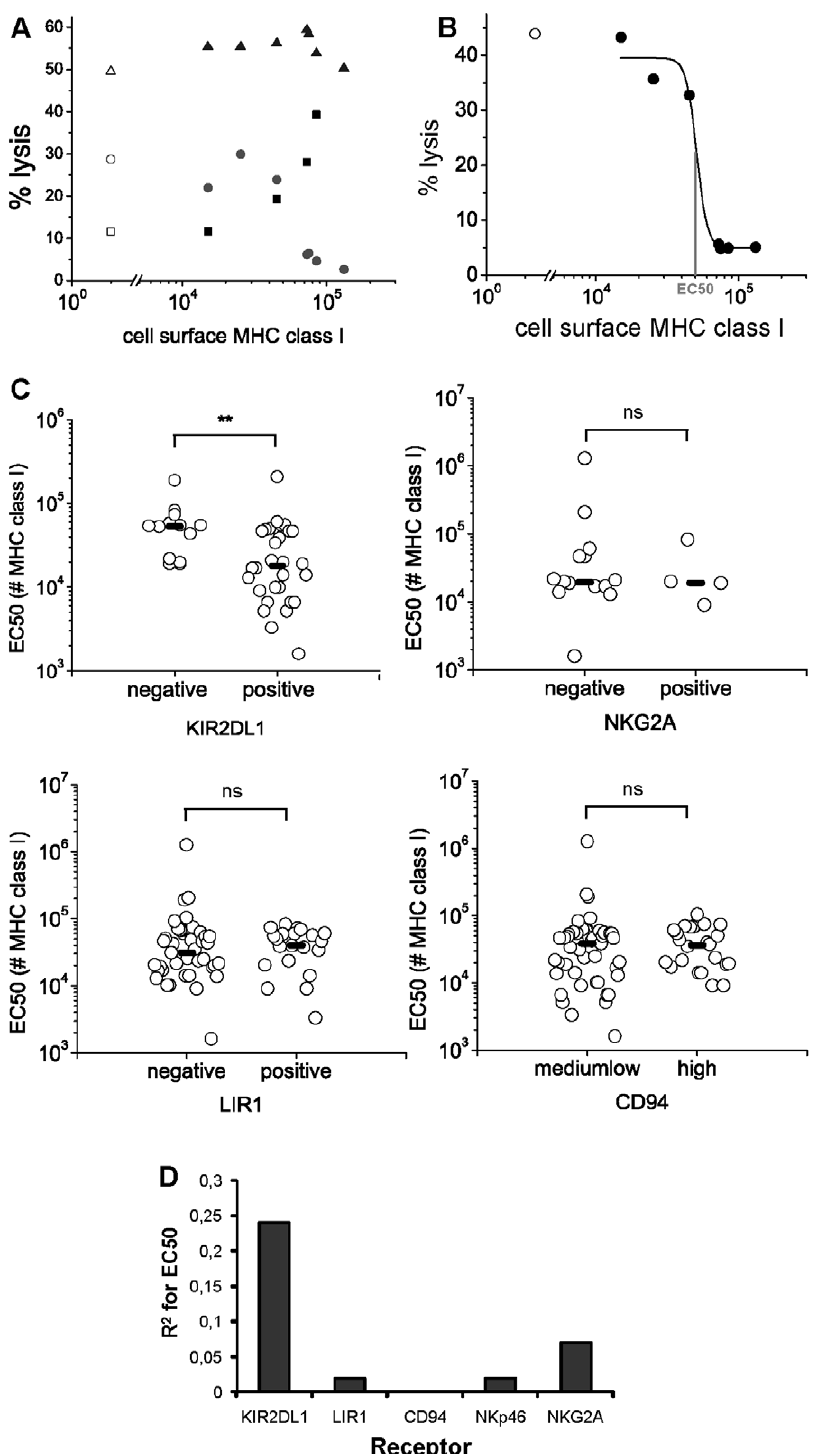
Figure 3. The threshold in MHC-I mediated NK cell inhibition depends on the expression level of KIR2DL1. A ) Lysis of different target cells by three NK cell clones, as determined by radioactive release assays, plotted against target MHC-I cell surface expression. Open symbols represent lysis of untransfected 221 cells. Circles show a clone inhibited by MHC; triangles show a clone not inhibited by MHC; and squares show a clone whose activity increased as function of target MHC level. B ) Lysis of target cells by one NK cell clone as a function of target MHC-I cell surface expression. A sigmoid curve was fitted to the data (using the Origin software) and the amount of MHC-I required to inhibit lysis to half its maximum, the EC50, was determined. C ) Where inhibition of lysis was observed, EC50 was determined for different clones phenotyped for KIR2DL1, NKG2A, LIR1 and CD94 expression. Each clone may express one or more receptors. Medians are indicated and statistical significance of differences was determined with the non-parametric Mann-Whitney test. **P , 0.005; ns, not significant. D ) Correlation between EC50 and receptor expression level, obtained by